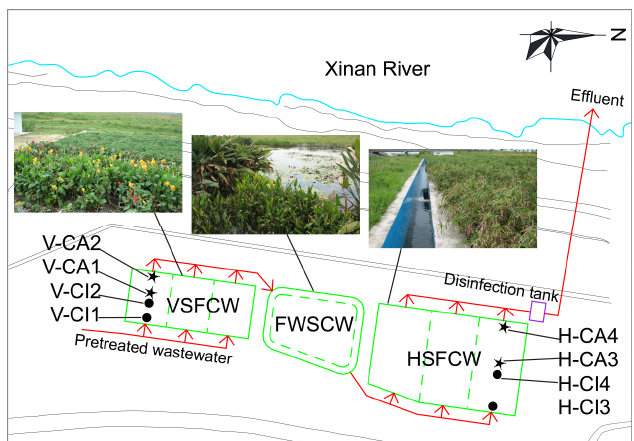
Figure 1. Geographic location, layout, photos and sampling locations of the study hybrid constructed wetland (HCW) system. V = VSFCW = vertical subsurface flow constructed wetland; FWSCW = free water surface constructed wetland; H = HSFCW = horizontal subsurface flow constructed wetland. Arrows show water flow direction in the system. Each circle represents the sampling locations of Canna indica (CI). Each star represents the sampling locations of Cyperus alternifolius